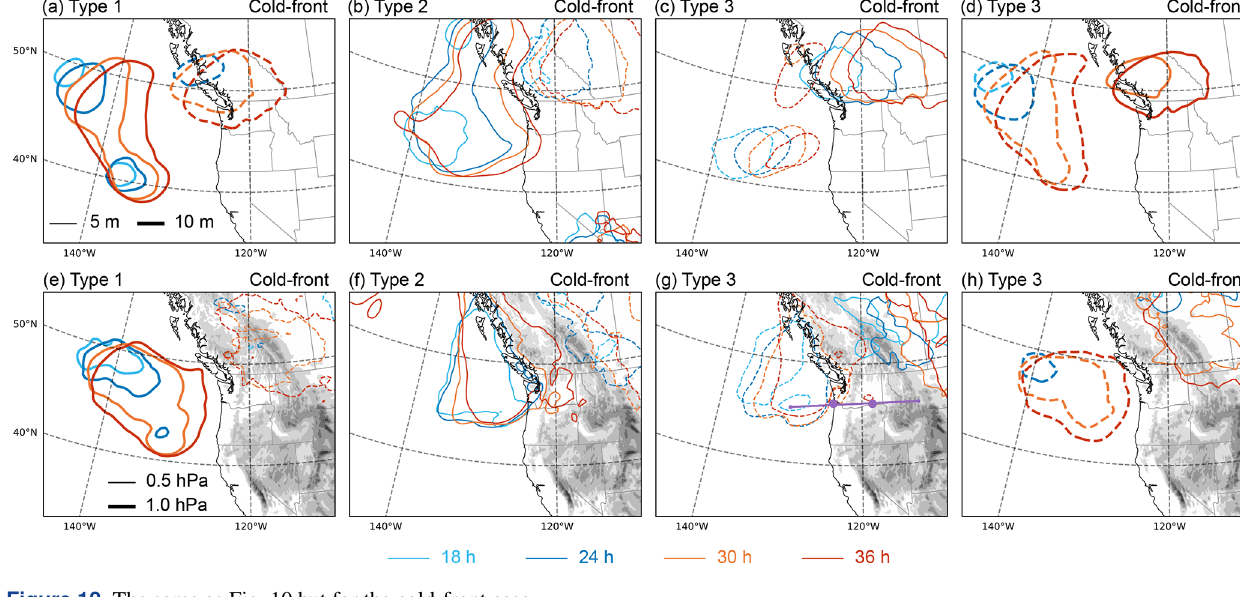
Figure 12. The same as Fig. 10 but for the cold-front case.